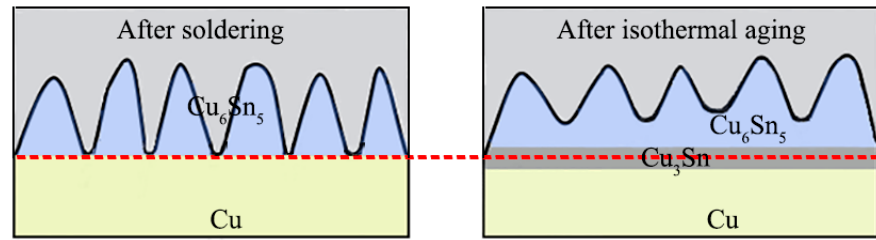
Figure 5. Interface position as a function of aging time and schematic illustration of the interfacial movement during aging: ( a ) after soldering, ( b ) interface position as a function of aging time, ( c ) isothermal aging 360 h, and ( d ) the schematic illustration of the interfacial movement.